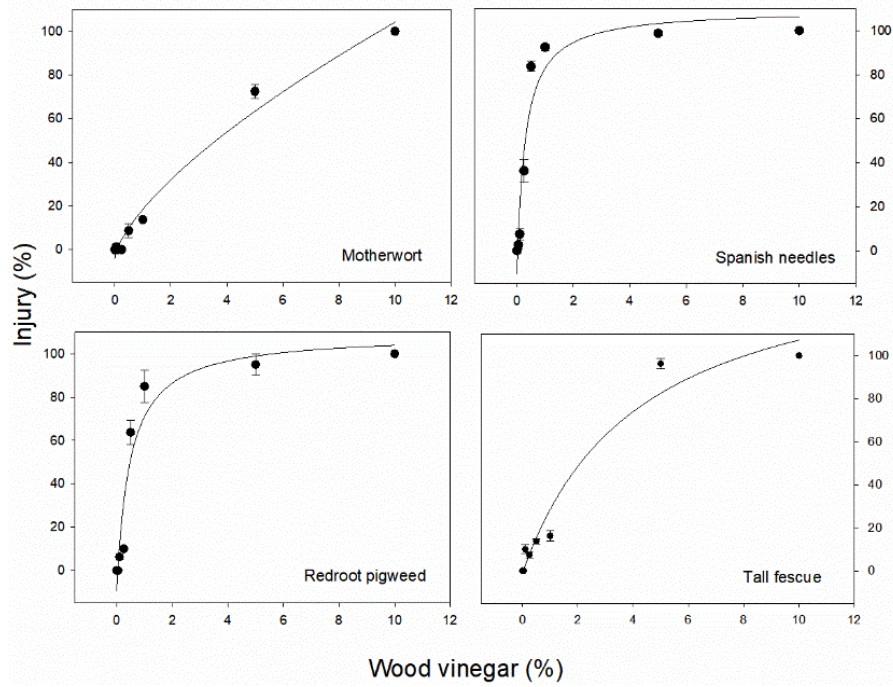
Figure 3. The impact of various wood vinegar concentrations on motherwort, Spanish needles, redroot pigweed, and tall fescue. Vertical bars represent standard errors of the mean ( n = 8).